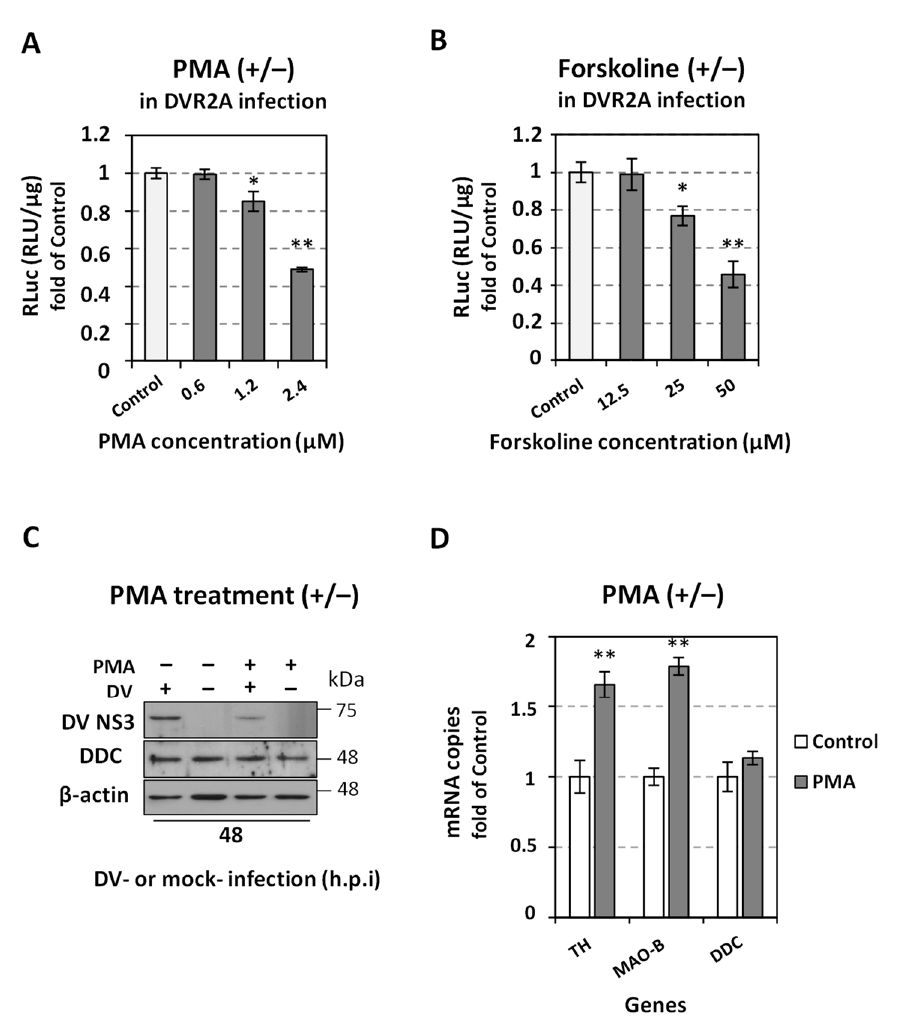
Figure 10. Inducers of catecholamine biosynthesis/metabolism pathway downregulate DV replication. Huh7 cells were inoculated with DVR2A ( A , B ) (MOI = 0.1) or DV ( C , D ) (MOI = 0.1), or were mock-infected (M), for 4 h and subsequently treated with the indicated concentrations of PMA ( A , C , D ) or Forskoline ( B ) or mock-treated (Control) for 48 h. ( A , B ) Levels of Renilla luciferase activity, indicative of dengue replication, were measured. Infected mock-treated cell values were set as one. * p < 0.01, ** p < 0.001 vs. Control. ( C ) In DV-infected (+) or mock-infected ( − ) cells, after virus inoculum removal, 2.4 µ Μ PMA or its solvent (Control) were administrated and cells were further cultured for 48 h. SDS-PAGE and immunoblot analysis were carried out in cell lysates, with the use of antibodies against the proteins DDC and β actin (loading control). Anti-NS3 antibody was used to confirm viral infection. ( D ) Mock-infected cells were treated with PMA (2.4 µ Μ ) and further cultured for 48 h. Mock-treated (Control) cells were used in parallel. RT-qPCR analysis was performed to determine the mRNA amounts of TH, MAO-B and DDC and the mRNA of the housekeeping gene YWHAZ was used for normalization. Control cell values were set as one. The mean values ± standard deviations from three biologically independent experiments in triplicate are presented. ** p < 0.001 vs. Control.